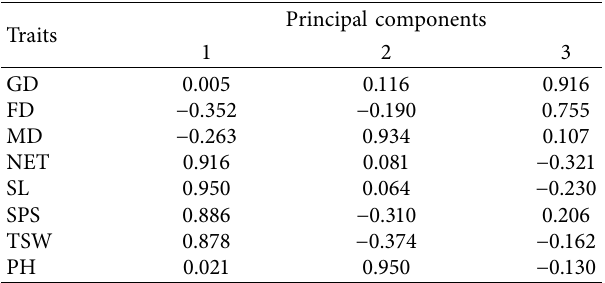
Table 7: Principal Component analysis for yield attributed traits of malt